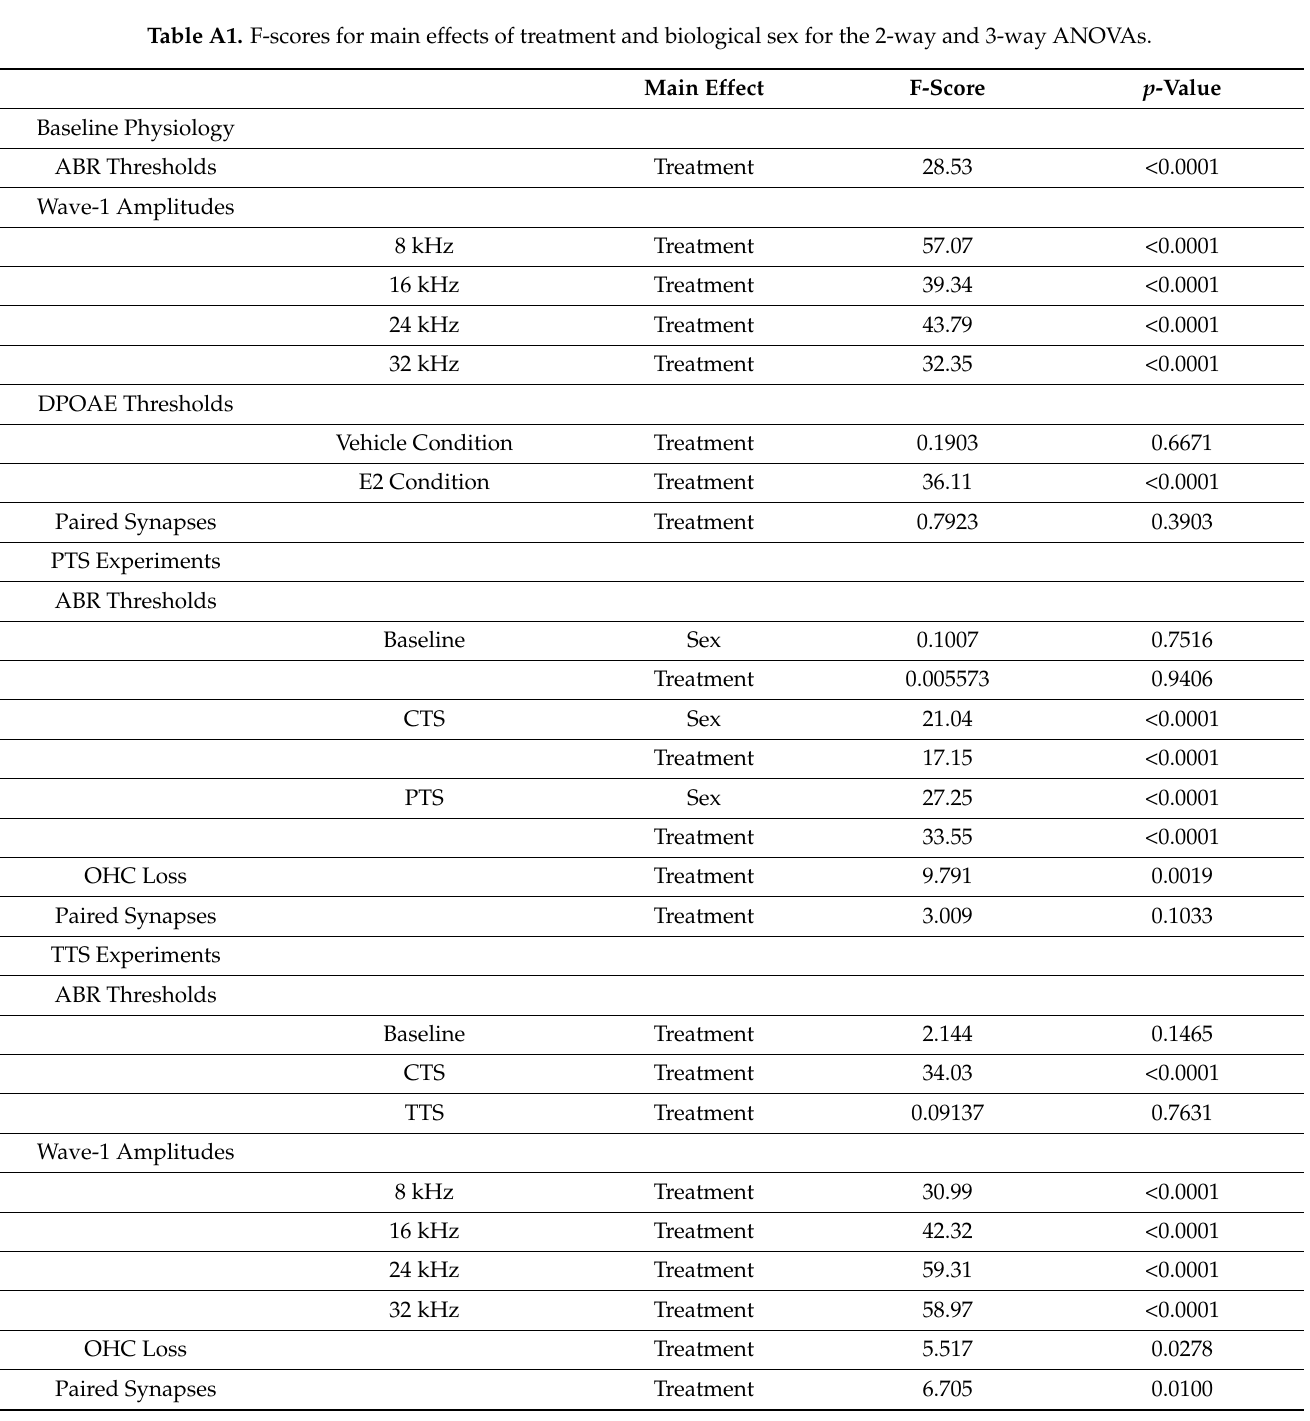
Table A1. F-scores for main effects of treatment and biological sex for the 2-way and 3-way